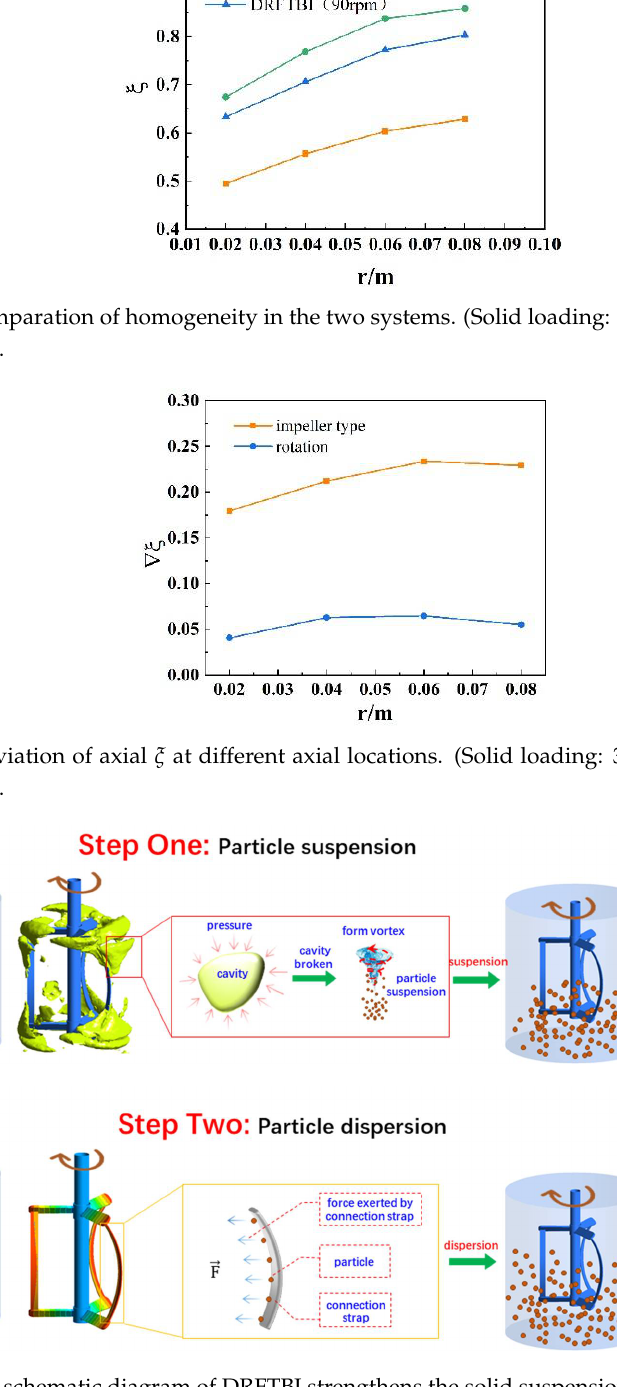
Figure 15. The schematic diagram of DRFTBI strengthens the solid